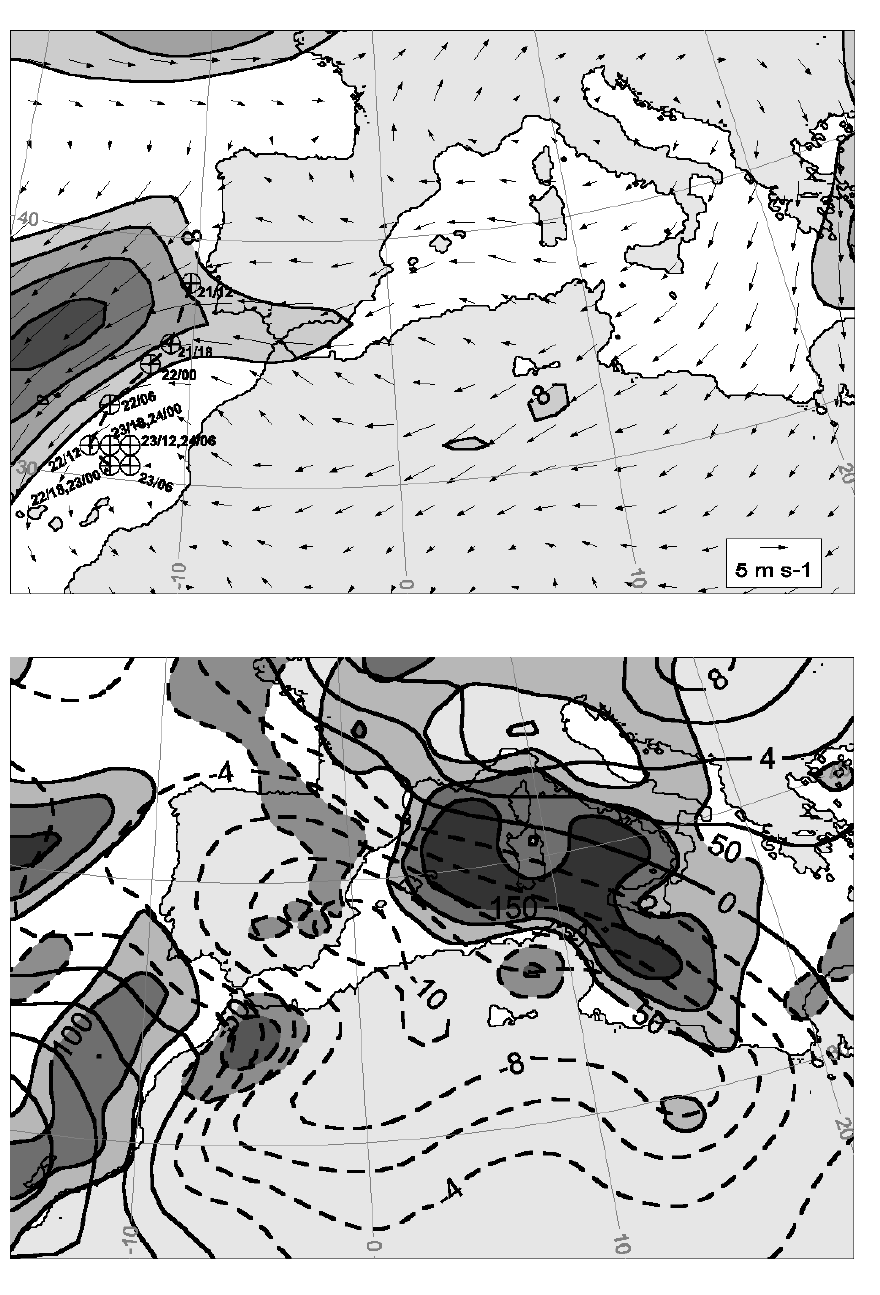
Fig. 18. Sea level pressure difference (hPa, solid and dashed lines indicate positive and negative values, respec- tively) between the control run and the weakened cutoff low precursor trough experiment on 12:00UTC, 23 Octo- ber 2000. Shaded contours indicate the latent heat flux difference (Wm − 2 ) greater than 50Wm − 2 (contour inter- val is 50Wm − 2 ) on 12:00UTC, 23 Oc- tober 2000. A zoom over the western Mediterranean from domain 1 is